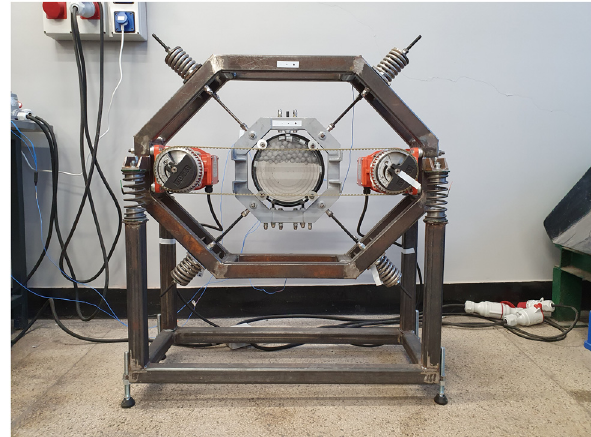
Figure 2: Photo of the